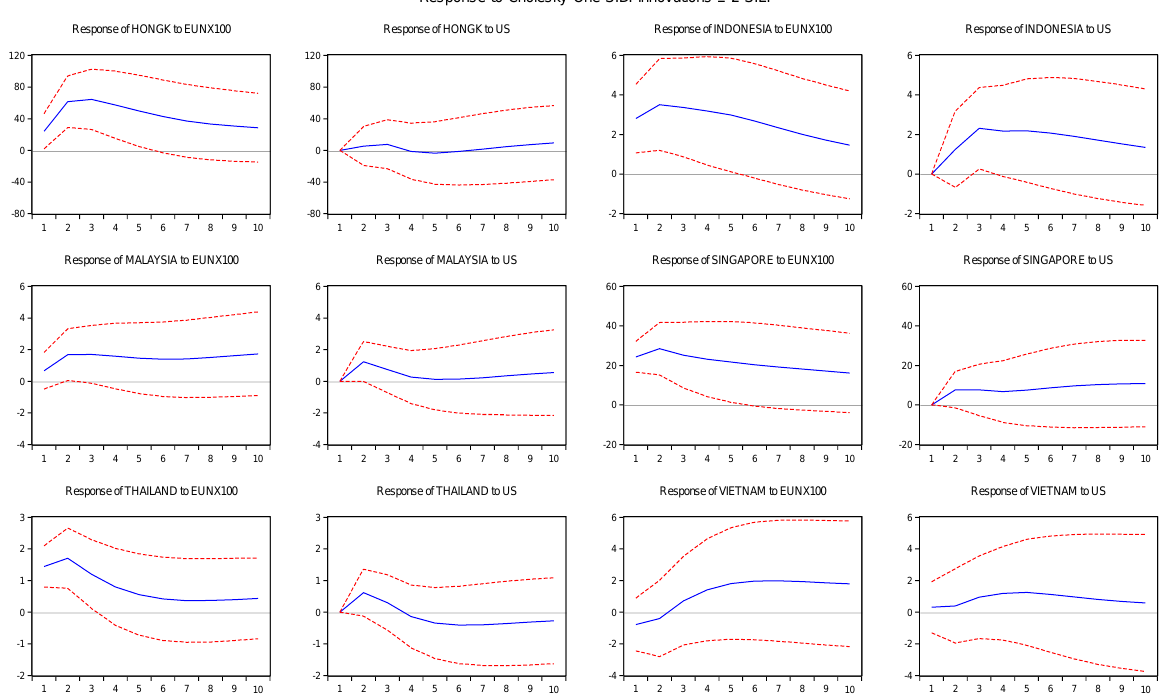
Figure 3. Response of Asian Stock Market to an Impulse in European and US Stock Markets During Ukrainian